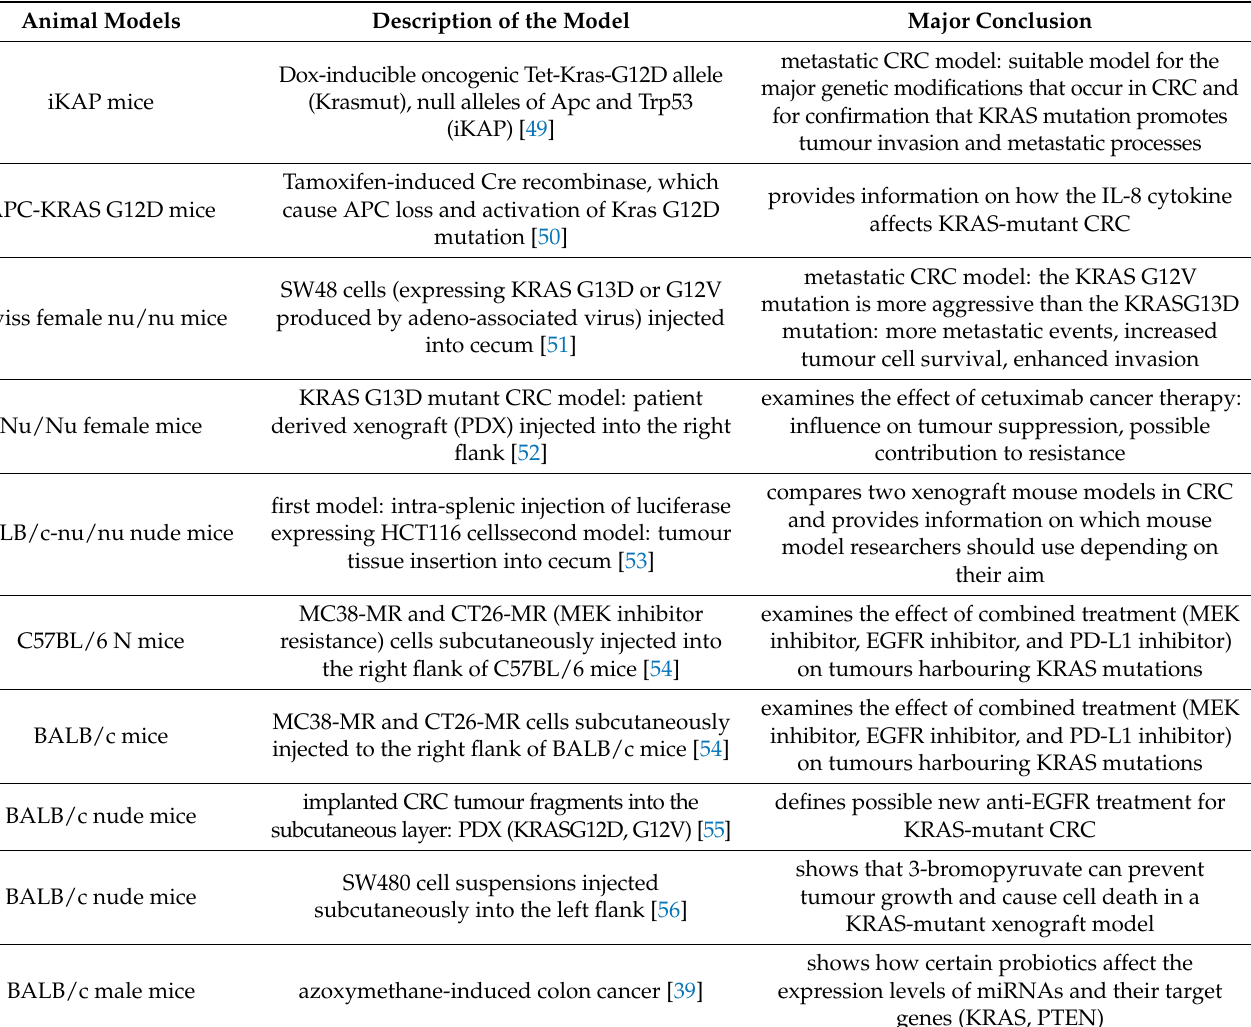
Table 3. Summary of the in vivo experimental model systems currently used in CRC research for understanding mutant KRAS-driven signalling in